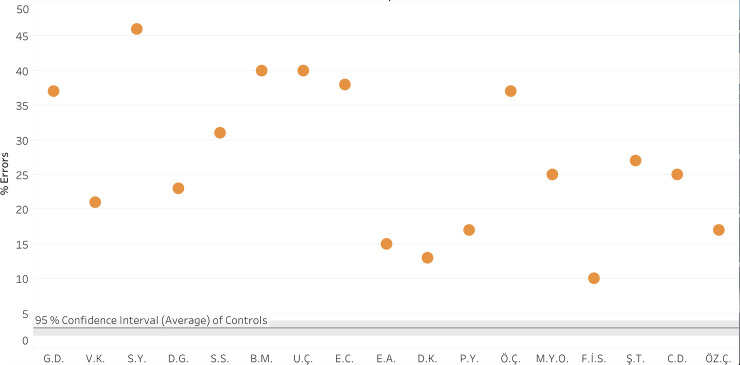
Reading nonwords: % vowel errors of each participant with vowel dyslexia (orange dots) compared to the control group average (horizontal grey line, and 95% CI around it).